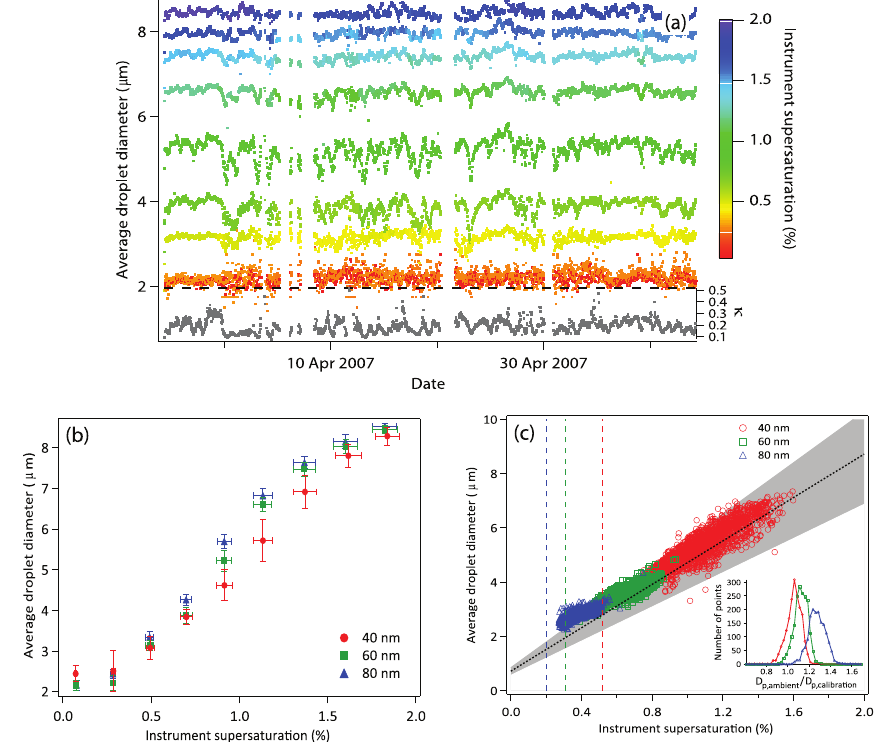
Fig. 10. (a) Temporal variation of droplet size for ambient 80nm particles color-coded by instrument supersaturation. κ values are shown in grey (right-hand scale). (b) Average droplet diameters for 40 (red circles), 60 (green squares), and 80nm (blue triangles). Vertical and horizontal error bars represent the standard deviation of measured droplet sizes and supersaturation, respectively. (c) Activated droplet sizes for 40 (red circles), 60 (green squares), and 80nm (blue triangles) ambient particles measured at supersaturations closest to the critical supersaturation of ammonium sulfate particles of the same respective size. The calibration curve is shown by a black dotted line while the grey area indicates the sizing uncertainty for the ammonium sulfate particles. Critical supersaturations for 40, 60, and 80nm ammonium sulfate particles are given by red, green, and blue dashed lines, respectively. Inset are histograms for each size particle indicating the occurrence of ratios of ambient wet droplet size to calibration wet droplet